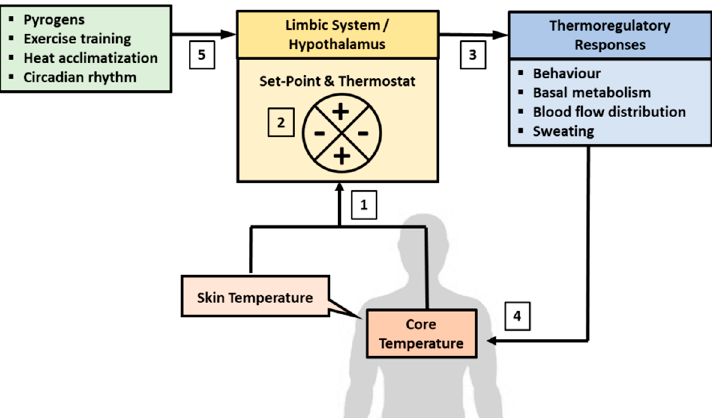
Figure 1. Central regulation of body temperature. Body temperature is regulated autonomously in the limbic system, which includes the hypothalamus. (1) The brain receives afferent signals on the state of body temperature from core (Tc) and skin (Tsk) temperatures. Tc is sensed from temperature of blood flowing to the brain and Tsk is derived from thermal sensitive nerves distribute all over the surface of the body. (2) The signals from Tsk and Tc are matched against the temperature set-point, which is about 36.8 °C in resting condition. (3) A departure from the set-point would activate a “thermostat” response through the autonomic nervous system to recalibrate body temperature back to the set-point. (4) The recalibration of body temperature may involve changes in behavior, blood flow distribution, basal metabolic rate adjustments, and the induction of sweating if heat loss is needed. (5) The temperature set-point can also fluctuate due to the influence of circadian rhythm, adaption to physical training, heat acclimatization, and pyrogens.